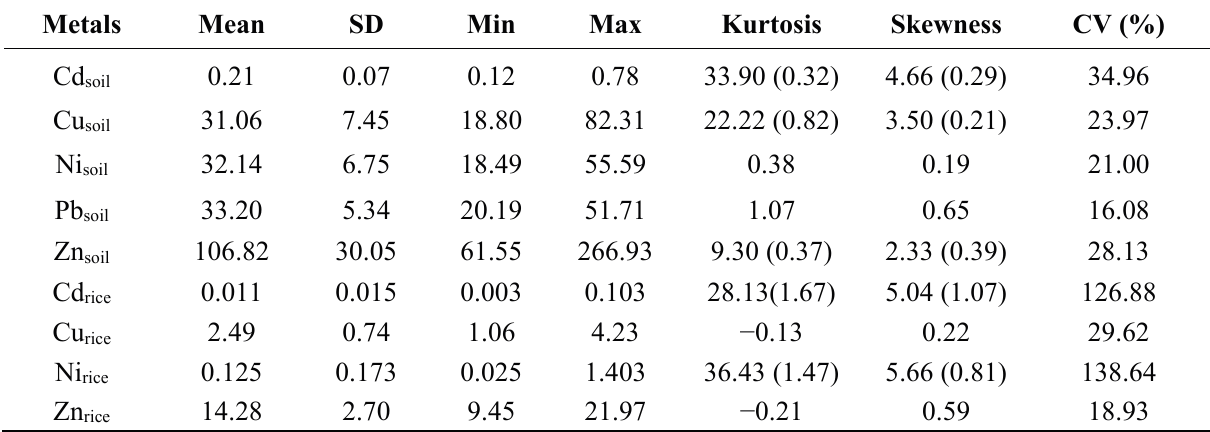
Table 2. Descriptive statistics for heavy metals in soils and rice (mg·kg − 1